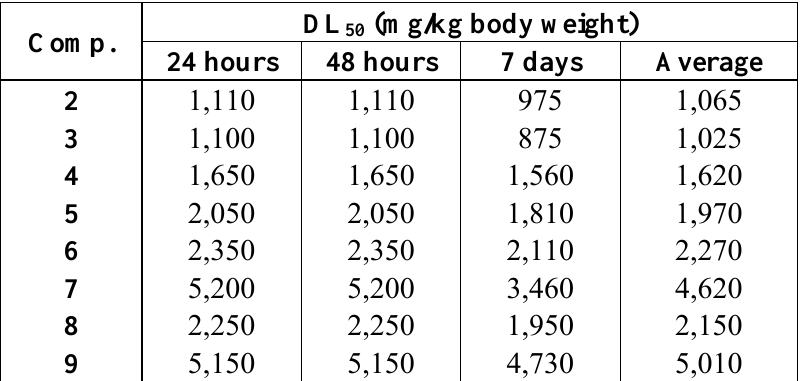
Table 1. DL values of the tested 50